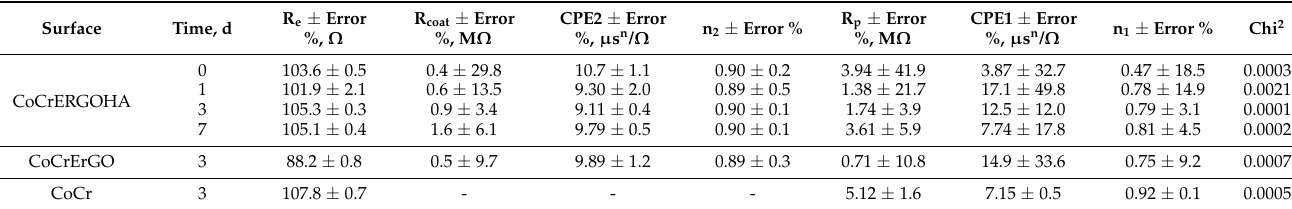
Table 2. Fitting values of the experimental impedance data using the equivalent circuits in Figure 3. R e : Electrolyte resistance; CPE1: Constant phase element and R p : Resistance related to metal surface/electrolyte interface; CPE2: Constant phase element and R coat : Ionic resistance due to the films deposited on the CoCr surface.